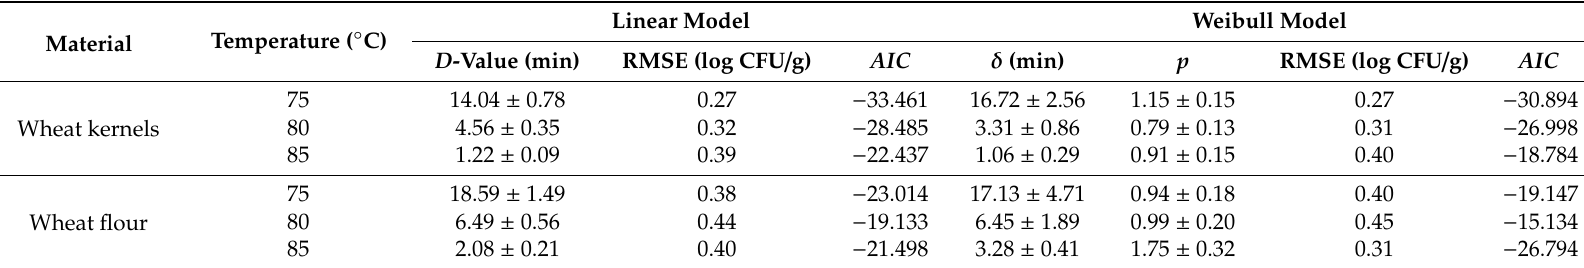
Table 2. Parameter estimates and RMSE for the primary thermal inactivation models of E. faecium NRRL-2356 inoculated in wheat kernels (a w = 0.66) (a) and flour (a w = 0.65) and heated at three temperatures with a fixed heating rate of 5 ◦ C / min in the heating block system (HBS) *.